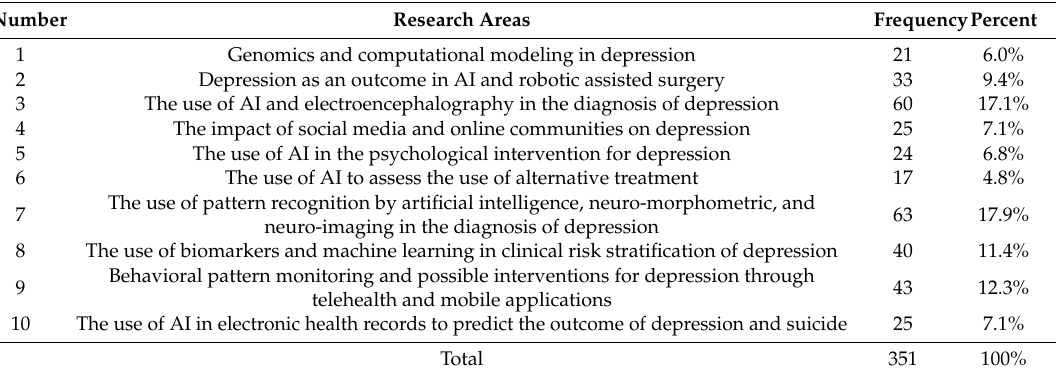
Table 5. Ten research topics classified by Latent Dirichlet Allocation.